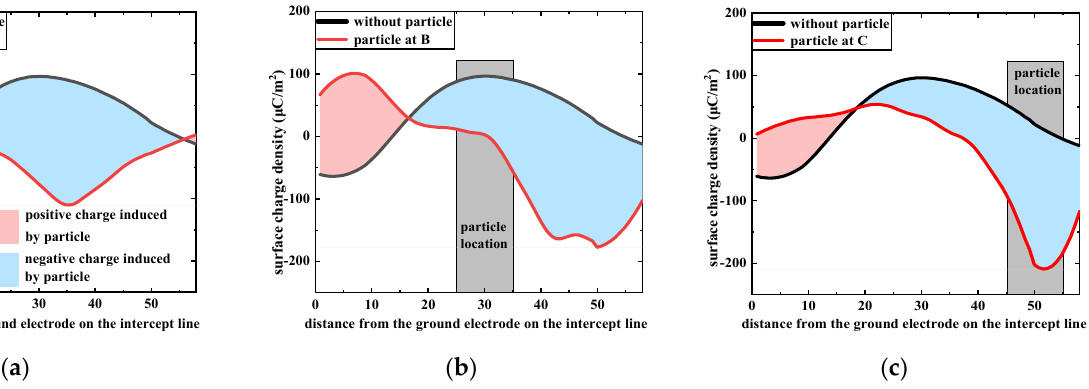
Figure 4. Surface charge distribution on intersection line of tri–post epoxy insulator with metal particle attached. ( a ) Particle at A; ( b ) Particle at B; ( c ) Particle at C. When metal dust is near the tri-post epoxy insulator, the metal dust is mainly adsorbed in the middle and top areas of the legs of the tri-post epoxy insulator, as shown in Figure 5a. The attached metal dust causes the polarity of the adjacent surface charges to change from positive to negative, forming a large area of negative charge spots on the leg surface of the tri-post epoxy insulator, as shown in Figure